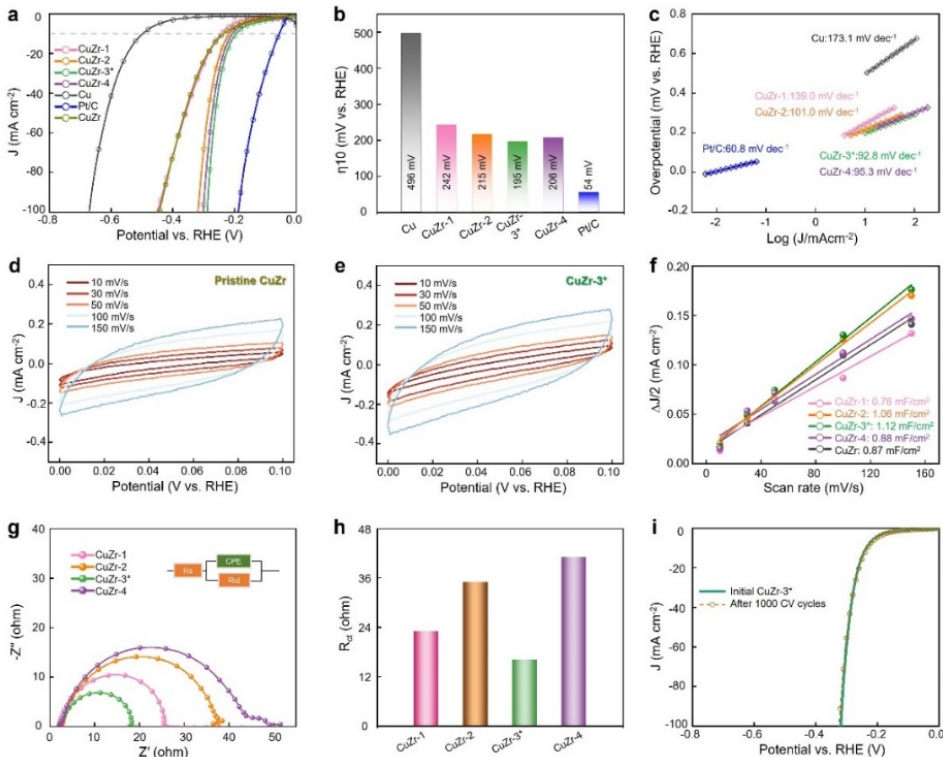
Figure 3. HER performance. ( a ) LSVs of the serial CuZr samples, Cu foil and Pt/C. The corresponding ( b ) overpotentials at 10 mA cm − 2 and ( c ) Tafel slopes. ( d , e ) CV curves from 10 to 150 mV/s for the pristine and CuZr − 3* samples. ( f ) The dependence of capacitive current densities with scan rates. ( g ) The Nyquist plots measured at the potentials corresponding to 10 mA cm − 2 . ( h ) The fitted value of R ct for each sample. ( i ) The LSVs of CuZr − 3* before and after accelerated durability test.